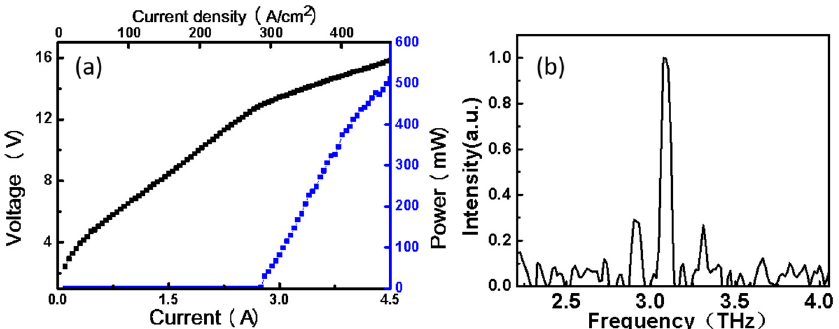
Figure 3. The P-I-V performance of dual ridges and typically multimode spectrum measured at 15 K. ( a ) Typical P-I-V curve of dual ridge device (2.8 mm × 175 µ m); ( b ) The typical lasing spectrum at ~15 K.